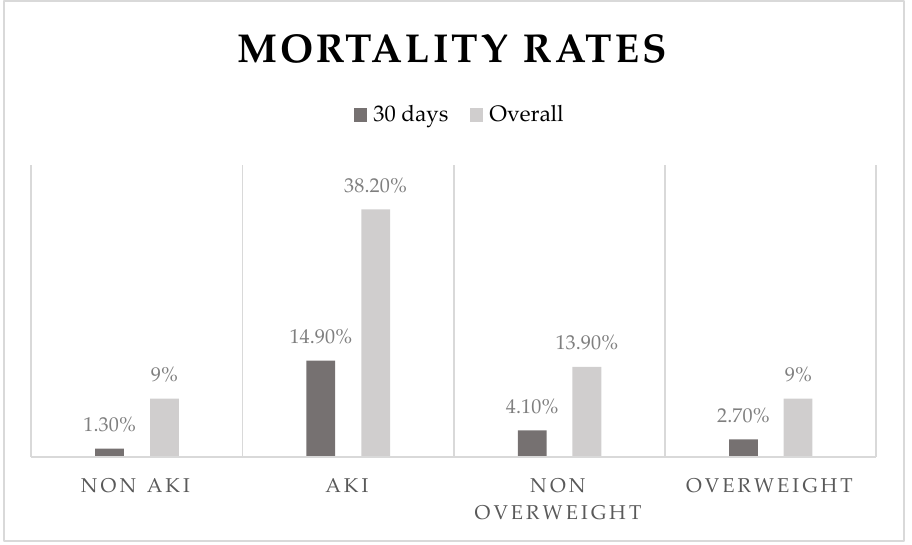
Figure 1. Mortality rates according to main effect.